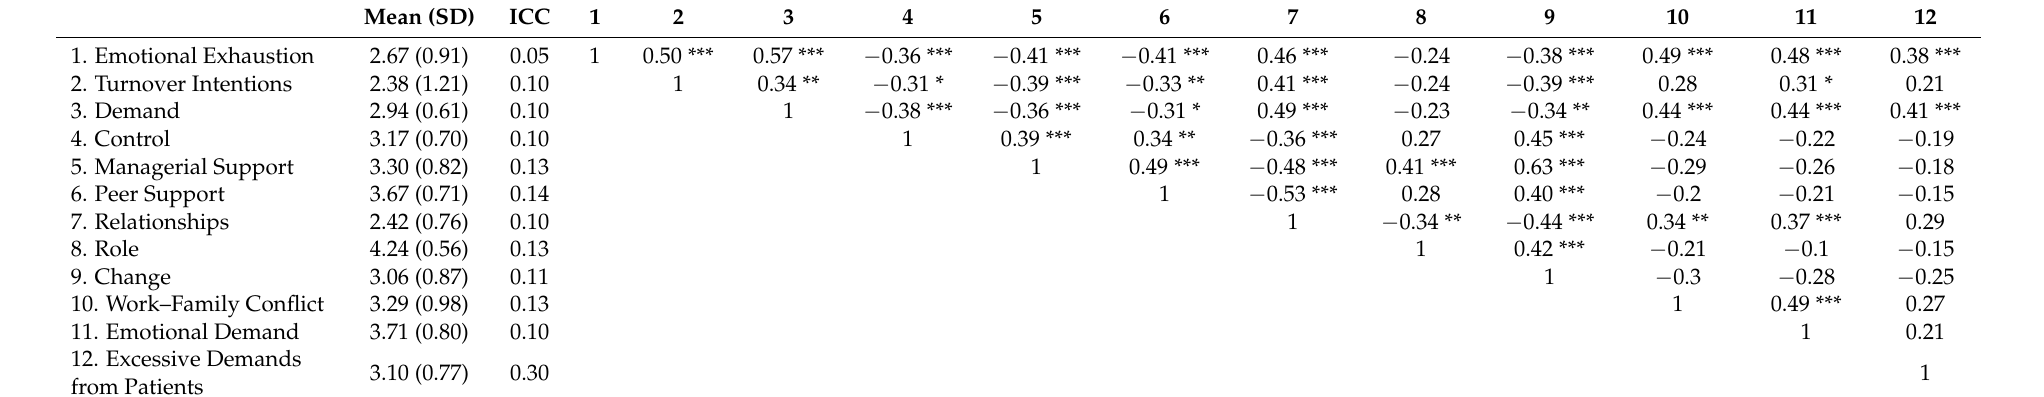
Table 1. Descriptive statistics and zero-order Pearson correlation coefficients between all included